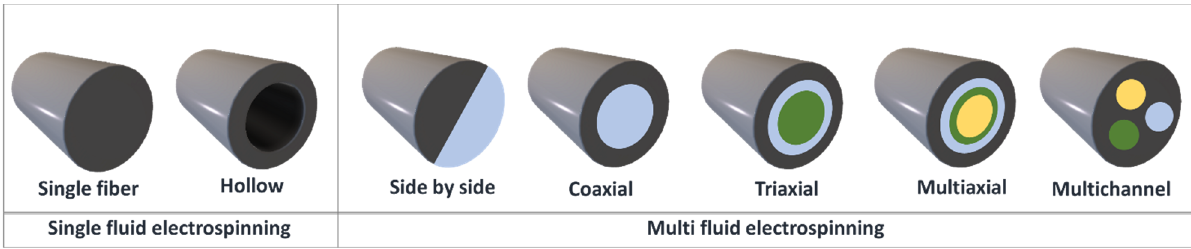
Figure 3. The cross ‐ sections of fibers generated using the various electrospinning approaches. Figure 3. The cross-sections of fibers generated using the various electrospinning